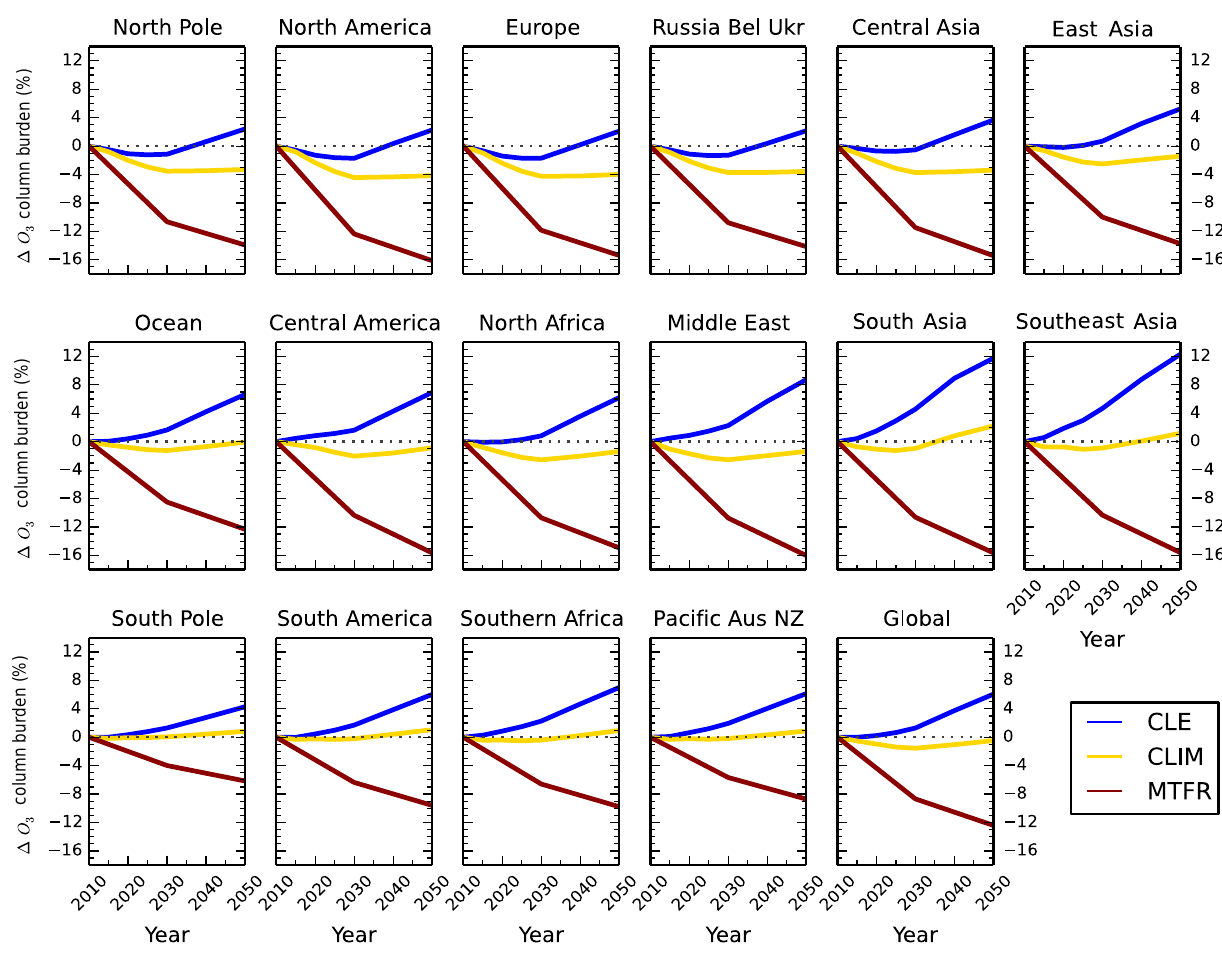
Figure 13. Annual mean percentage change in the regional and global tropospheric O 3 burden over the period 2010 to 2050 from the parameterisation for the ECLIPSE V5a emissions under CLE (blue), CLIM (gold) and MTFR (red)